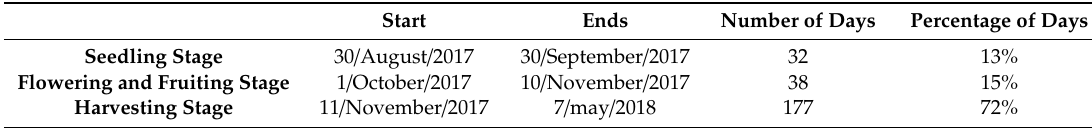
Table 1. Three stages of the crop production